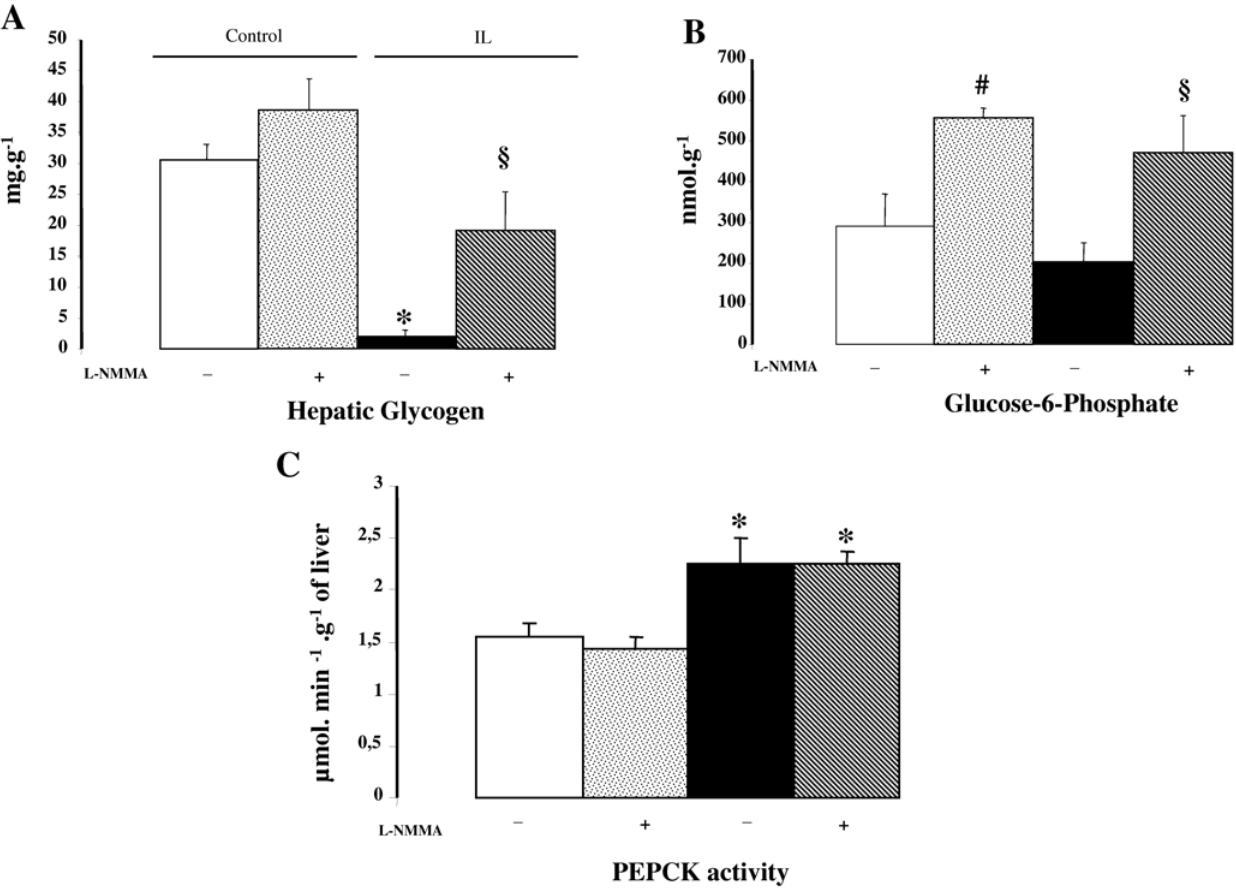
Figure 6. Hepatic parameters during euglycemic-hyperinsulinemic clamp procedure. A: Glycogen content, B: Glucose-6-Phosphate content, C: PEPCK activity in the liver of control and IL rats (injected or not with non selective NOS inhibitor, L-NMMA) at the end of the clamp procedure. Values are means 6 SEM in each group. * p , 0.01 vs. C rats; 1 p , 0.01 vs. IL rats.